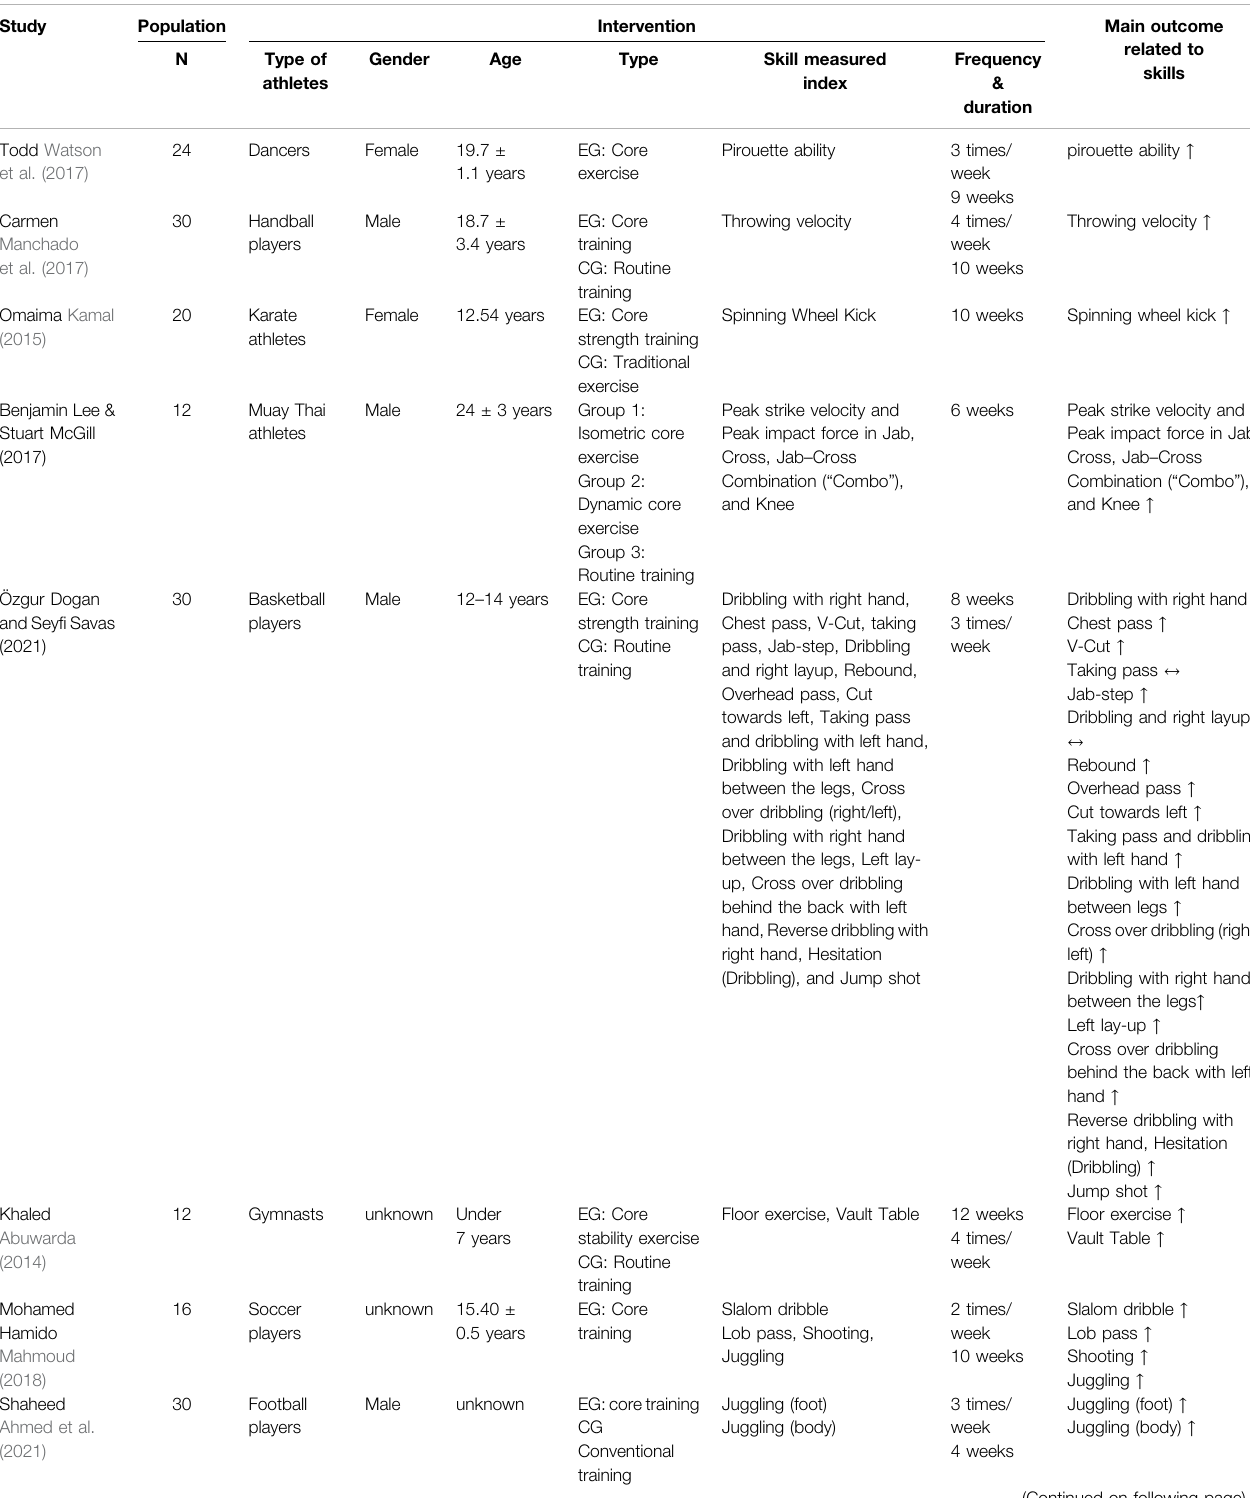
TABLE 3 | Population, Intervention and Main